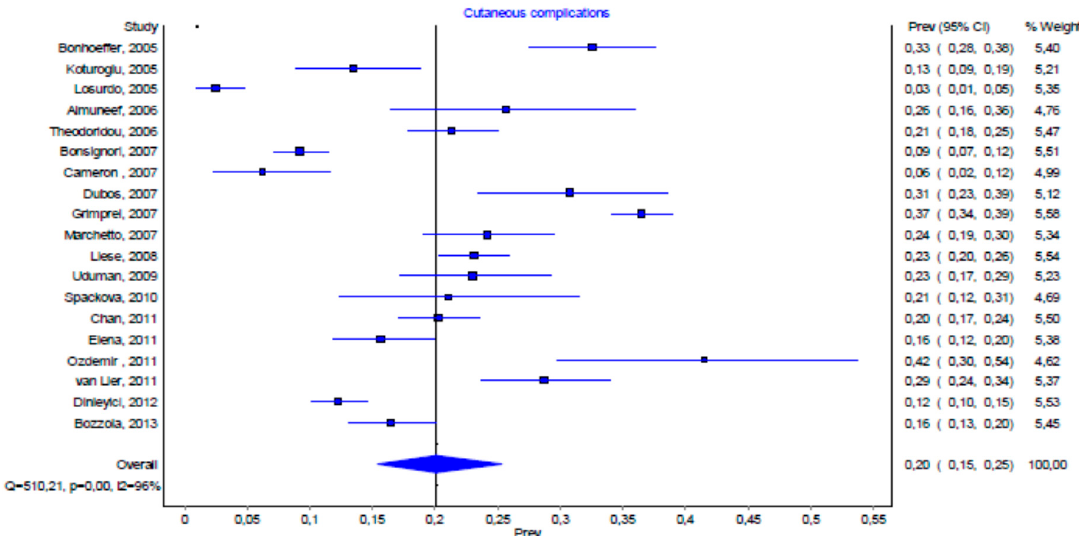
Figure 2. Prevalence of varicella skin complications (VSCs) in hospitalized patients (the % weight of the studies is calculated on the inverse of the variance by using the DerSimonian and Laird method).